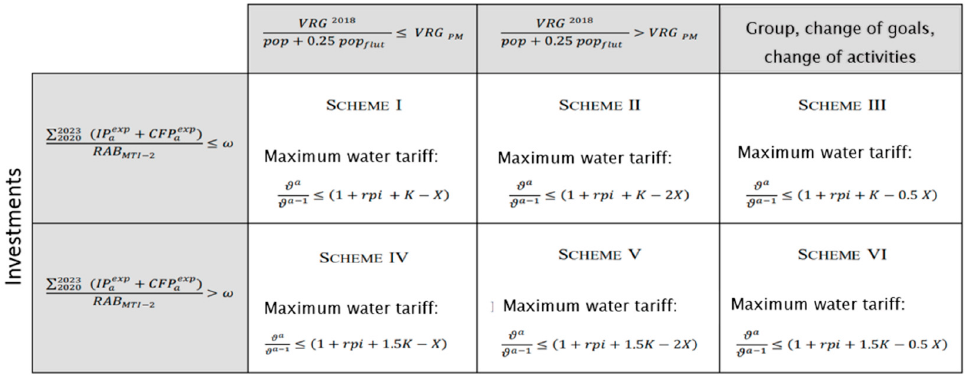
Figure 2. The regulatory schemes’ matrix by ARERA Resolution 580/2019/R/ID.